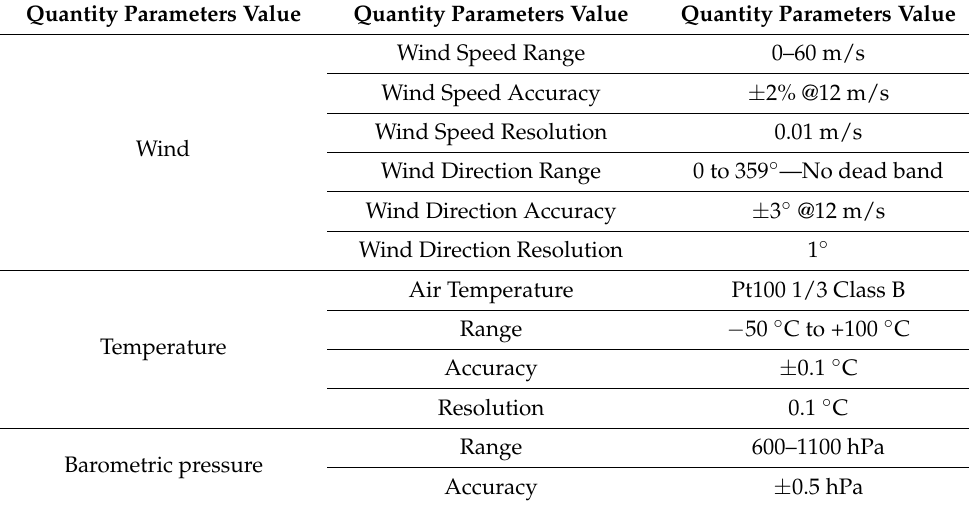
Table A2. Technical characteristics of the used